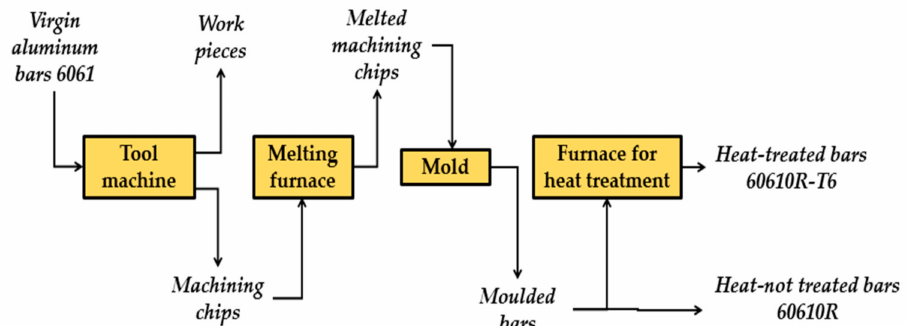
Figure 1. Process for obtaining recycled aluminum alloys.